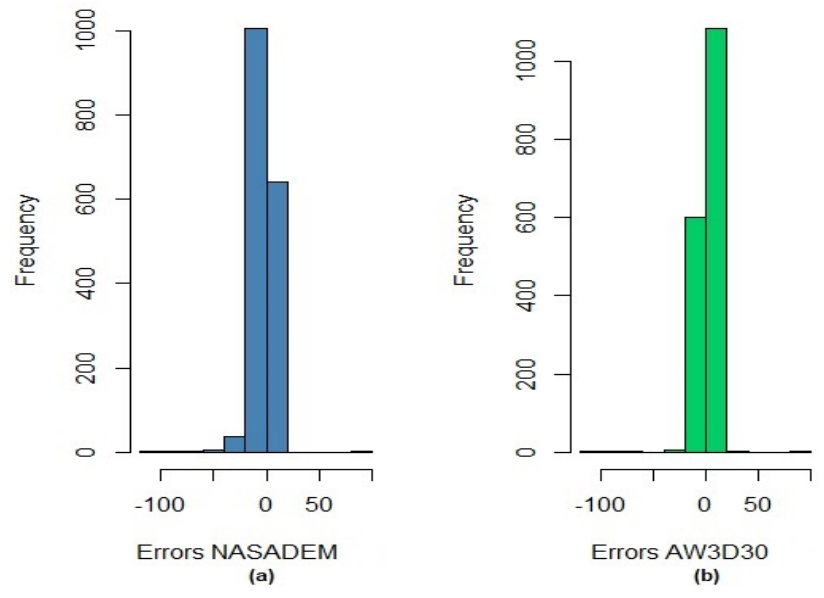
Figure 7. Histograms of altitude discrepancies for NASADEM_HGT ( a ) and AW3D30 ( b ).